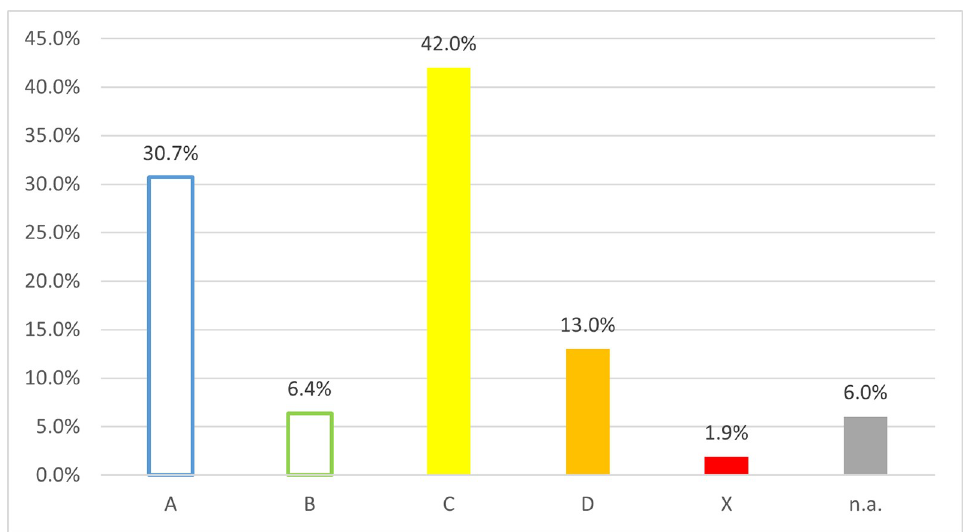
Fig 4. Distribution of interactions by UpToDate Lexiomp 1 risk classification grades [43]. A: No known interaction, B: No action needed, C: Monitor therapy, D: Consider therapy modification, X: Avoid combination; n.a.: Not available; n =